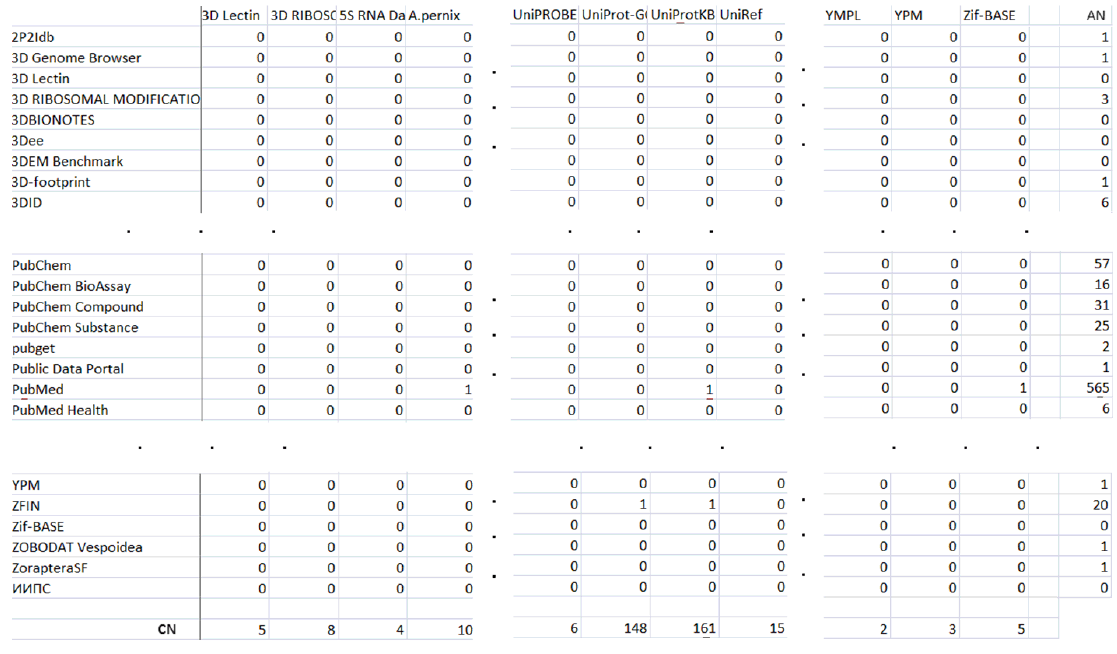
Figure 4. Partial picture of the Interconnection matrix. The cell in line I, colon J, has a value of one if the microbial database J has a database I in the list of its partners; otherwise, it has value zero. The CN is the last bottom line of the matrix, AN is the right column. Top line—acronyms of microbial databases; left column—acronyms of all Life Science databases.